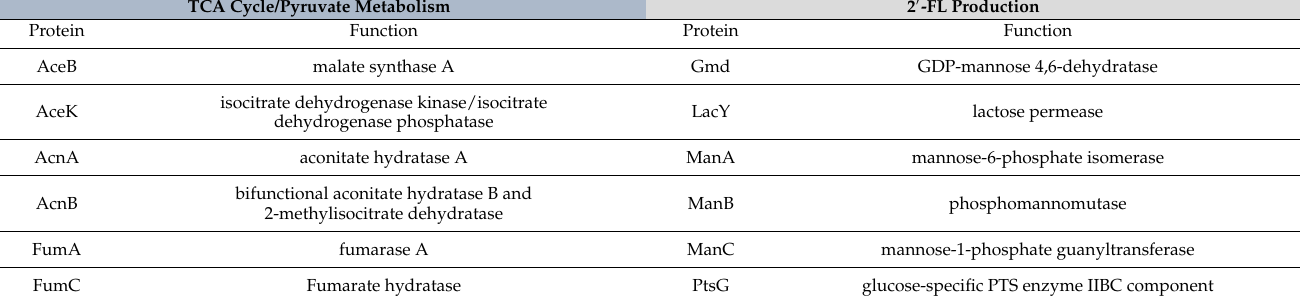
Table A2. The list of proteins included in the targeted search in the proteomics dataset. The list is divided into three functional groups: TCA cycle and pyruvate metabolism, 2FL production pathway, and Decarboxylation/carboxylation related